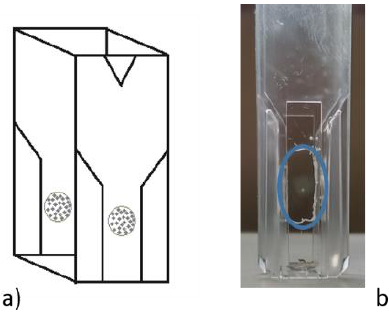
Figure 1. ( a ) Schematic representation of the covered areas on polystyrene cuvette, ( b ) photograph of the cuvette after the deposition process, used for the experimental